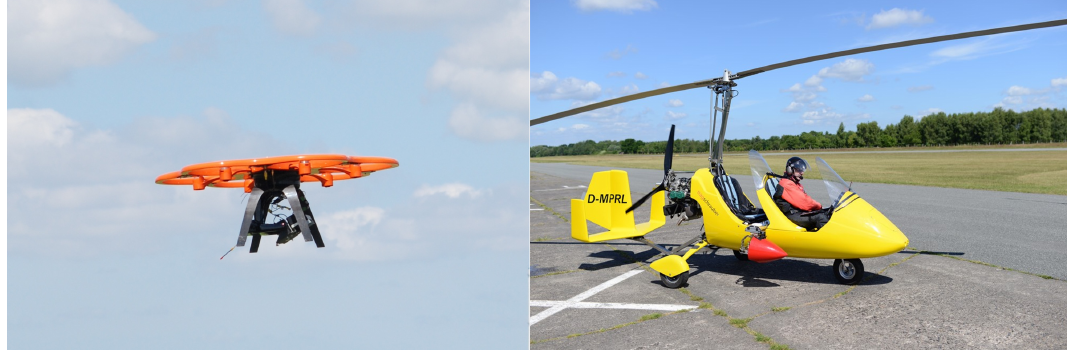
Figure 3. Flight platforms used for the survey: hexacopter with a camera system on a gimbal ( left ) and gyrocopter with the camera system to the pilot’s right under the red cover ( right